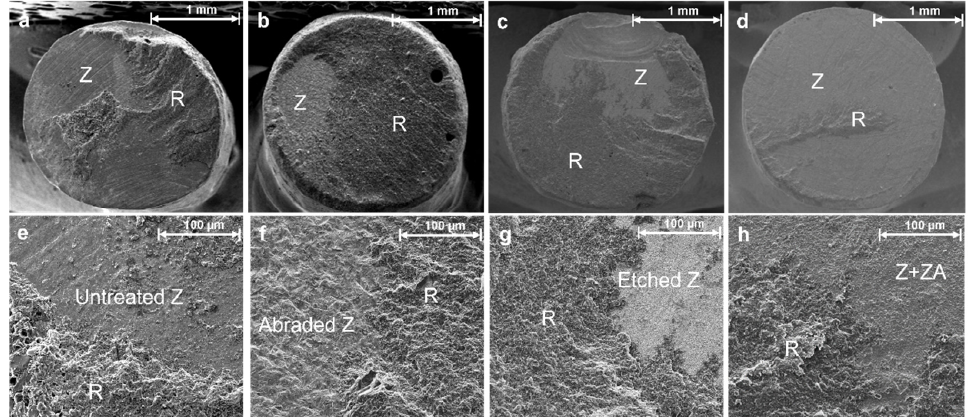
Figure 4. Scanning electron microscopy (SEM) images showing the mixed failure modes in Groups ( a , e ) 1, ( b , f ) 2, ( c , g ) 3, and ( d , h ) 4. Each pair of images was acquired at 50× and 1000× magnifications, respectively. Z, R, and ZA in the images represent zirconia, resin cement, and the ZirADD coating, respectively.